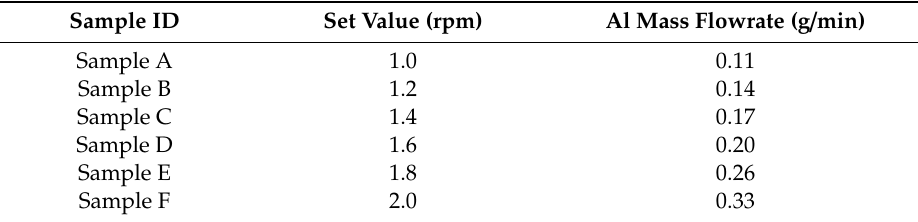
Table 1. Aluminum mass flow rates.